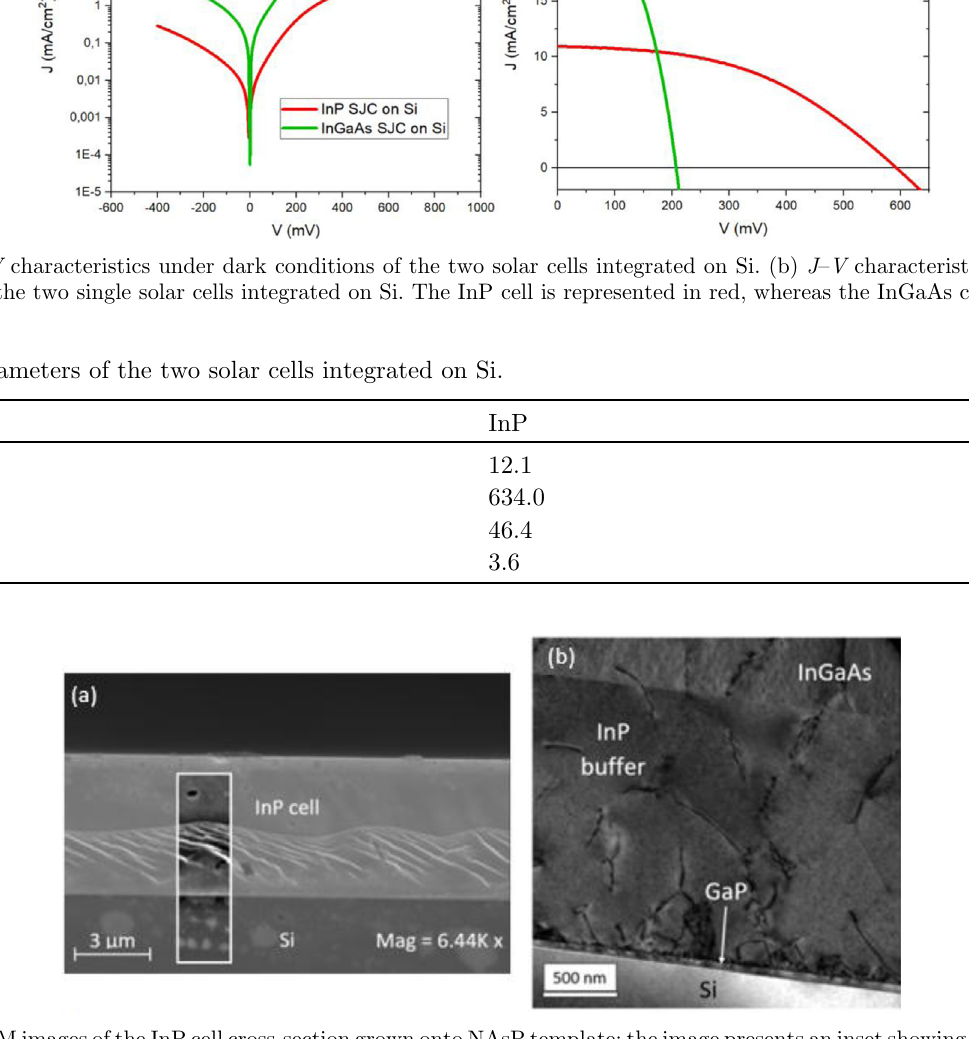
Fig. 10. (a) SEM images of the InP cell cross-section grown onto NAsP template; the image presents an inset showing band-pass fi lter treatments performed with ImageJ software to highlight the irregularities. (b) TEM images of the cross section of the grown InGaAs single solar cell displaying a part of the InGaAs base with the presence of